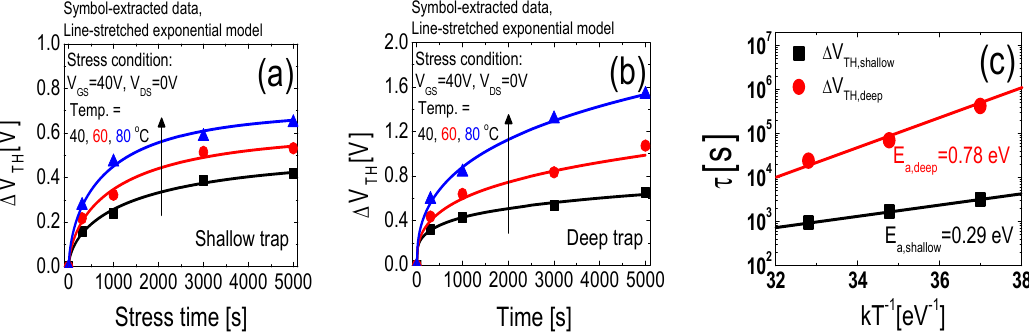
Figure 6. ( a ) Dependence of ∆ V TH ( t ) on stress temperature for the electrons trapped in the shallow trap under PBTS ( V GS = 40 V, V DS = 0 V, t st = 5000 s). ( b ) Dependence of ∆ V TH ( t ) on stress temperature for the electrons trapped in the deep trap under PBTS. ( c ) Characteristic time constant as a function of the PBTS temperature to extract the effective energy barrier (activation energy), for each trap.